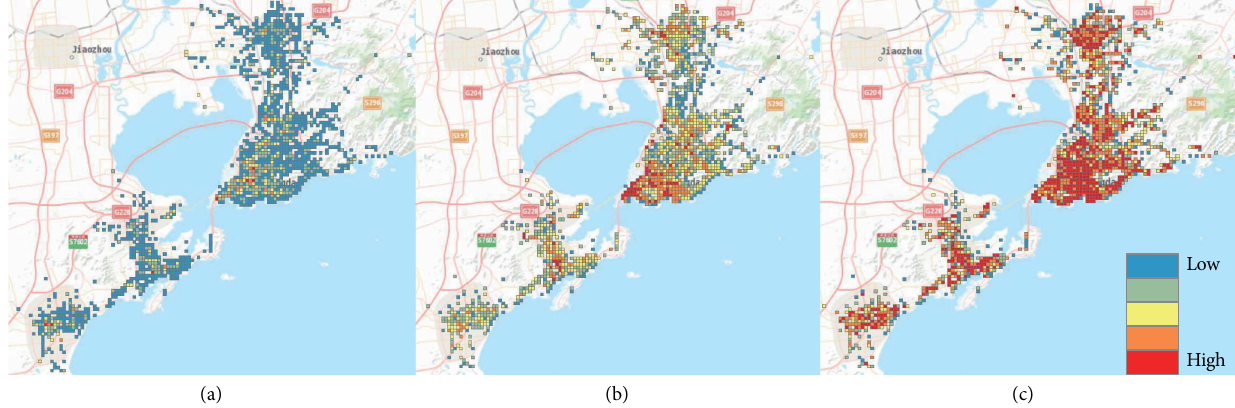
Figure 7: The distribution of main POIs (a) residential density (b) road density (c) land use